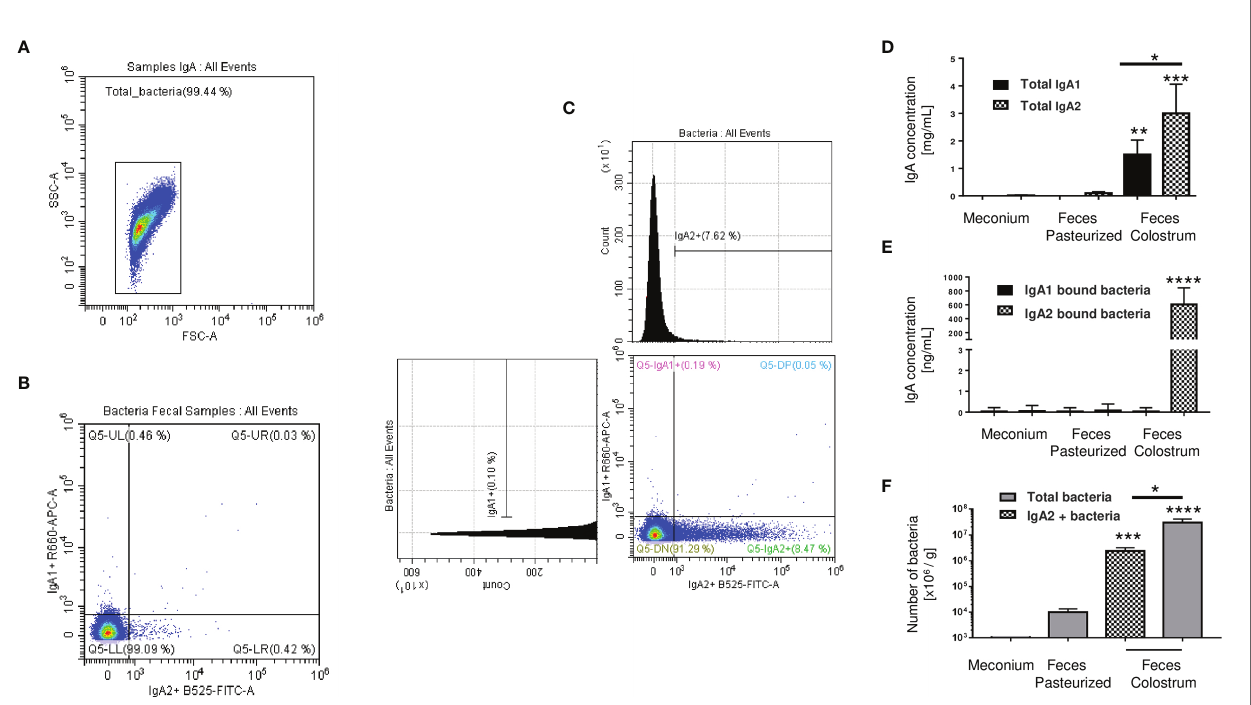
FIGURE 3 | IgA2 is predominantly found coating bacteria in newborn feces of breastfed children. (A) Dot blot of total bacteria in neonate ’ s fecal samples. (B) Bacteria found in meconium characterized by fl ow cytometry. (C) Bacterial populations coated with IgA subclasses in stool samples. Plots are representative of fi ve pool meconium (B) and nineteen feces ’ samples (C) , obtained after three days of colostrum-fed newborn children. (D) Quanti fi cation by ELISA of IgA subclasses in “ Meconium, ” a stool sample from children fed with pasteurized milk, titled “ Feces Pasteurized, ” or children fed with maternal colostrum, titled “ Feces Colostrum ” ; data are expressed in milligrams of IgA per gram of fecal sample (mg/g). (E) Semi-quanti fi cation by Western blot of IgA subclasses ’ levels bound to bacteria; data are expressed in nanograms of IgA per gram of fecal sample (ng/g). IgA1 (black bars) and IgA2 levels ( fi lled bars). (F) Number of bacteria determined by fl ow cytometry; data are expressed in millions of bacteria per gram of fecal sample (10 6 bacteria/g). IgA2+ ( fi lled bars) and total bacteria (gray bars). Bars indicate the mean ± SD of triplicates from fi ve “ Meconium, ” twenty-seven “ Feces Pasteurized, ” and nineteen “ Feces Colostrum ” samples. Statistical analysis was performed using the Mann- Whitney U test between IgA subclasses in the same sample and comparing each level with feces pasteurized levels as control. *p < 0.05, **p < 0.01, ***p < 0.001 and ****p <